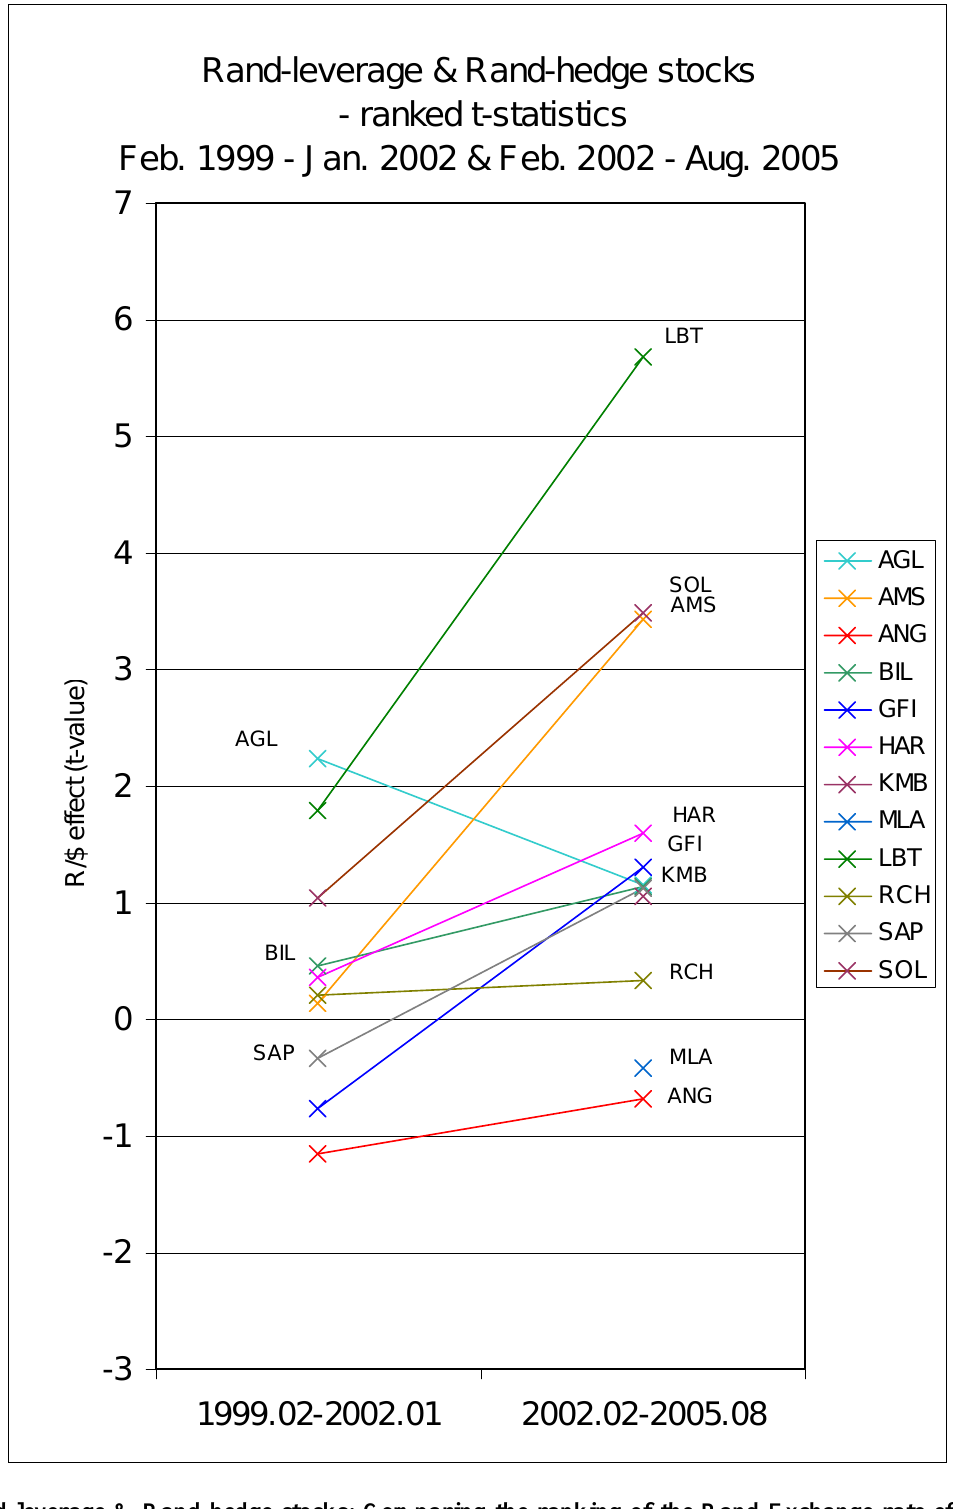
Figure 3: Rand-leverage & Rand-hedge stocks: Comparing the ranking of the Rand Exchange rate effect (t-statistic) over the periods February 1999 to January 2002 with February 2002 to August